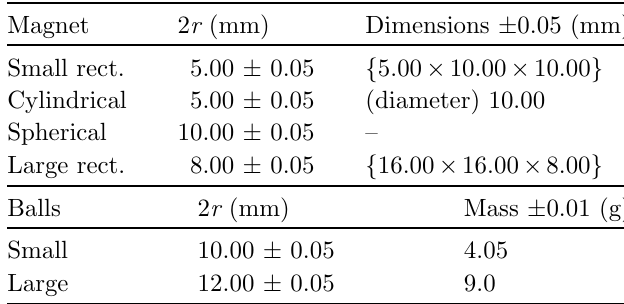
Fig. 1. A sketch of our system. Red and blue colours depict the poles of the magnet. An incoming ball collides with the line of balls and magnet, and the fi nal ball in the line is ejected with Table 1. Magnet and ball dimensions and ball masses. The side of the magnet that is parallel to the line of balls and the magnetization is denoted 2 r .